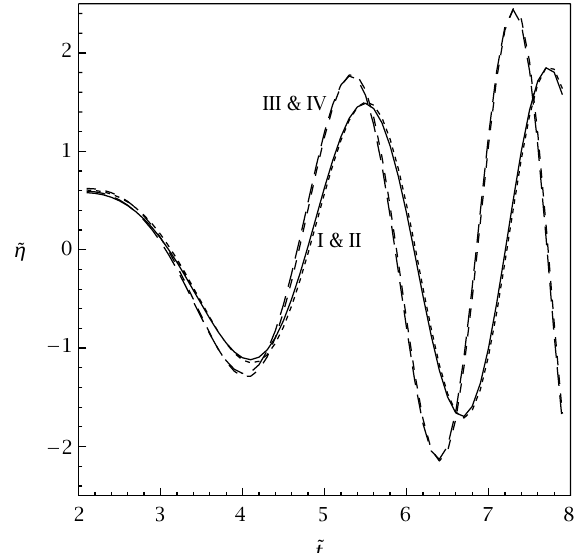
Figure 5.2 . Wave profiles due to an initial disturbance in the form of an initial depression ( ˜ x = 1 . 0 ) , (cid:5)/h = 0 . 01, N 2 h/g = 0 . 1 I; (cid:5)/h = 0 . 01, N 2 h/g = 0 . 0 II; (cid:5)/h = 0 . 0, N 2 h/g = 0 . 1 III; (cid:5)/h = 0 . 0, N 2 h/g = 0 . 0